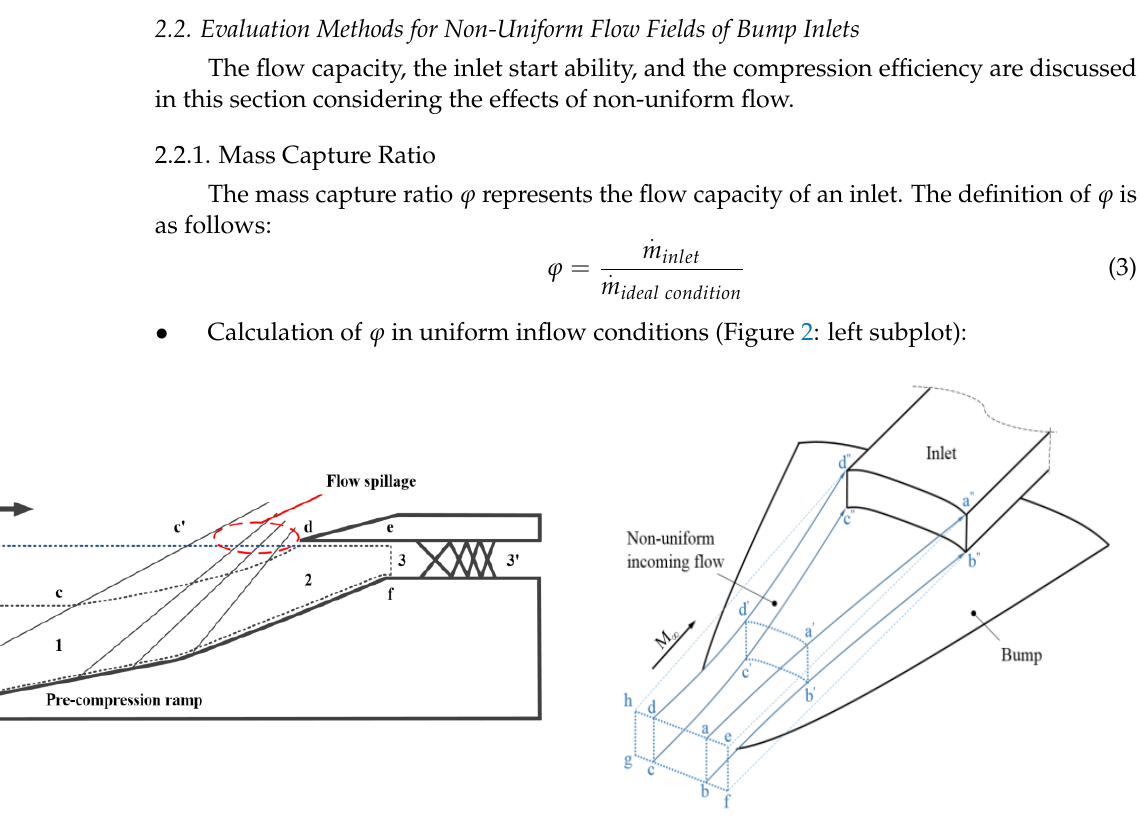
Figure 2. Schematic of obtaining the inlet’s mass capture ratio: left , uniform inflow condition; right , non-uniform inflow condition.